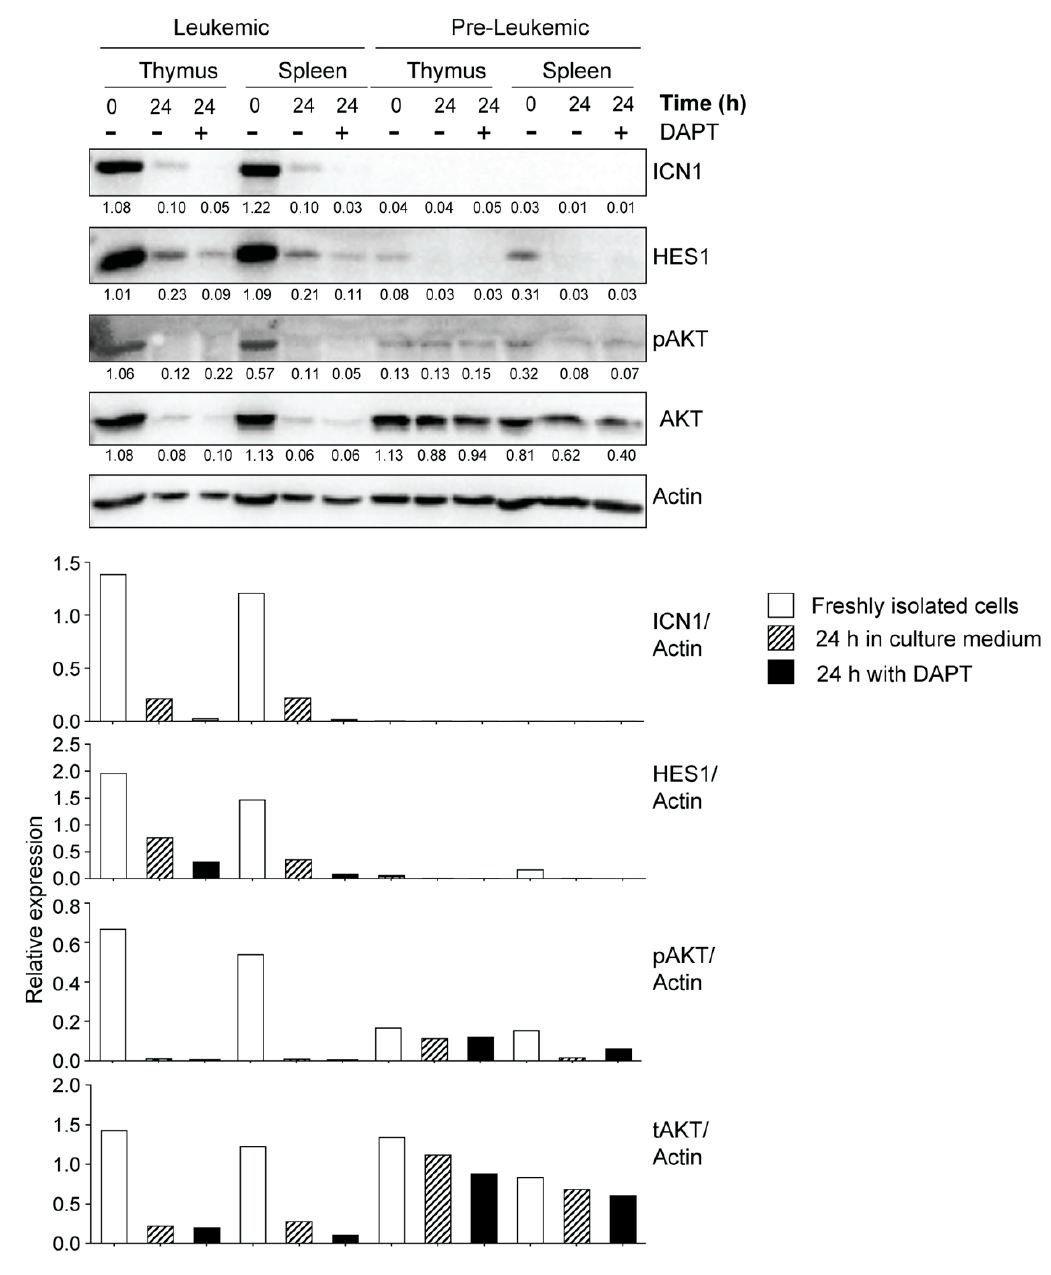
Figure 6. NOTCH1 expression in primary leukemic and pre-leukemic cells from IL-15-deficient Scid mice. Freshly isolated single-cell suspensions from thymus (pooled from at least 2–3 mice) or spleen were lysed immediately after isolation or 24 h after incubation in the presence or absence of DAPT (10 µ M) and analyzed for the expression of ICN1, HES1, phospho-AKT and total-AKT. Representa- tive data from one of the two similar experiments are shown. The densitometry quantification of ICN1, HES1, pAKT and tAKT bands normalized to the corresponding actin band for each sample is graphically represented below the blots. Original Western blots are given in Supplementary Figure